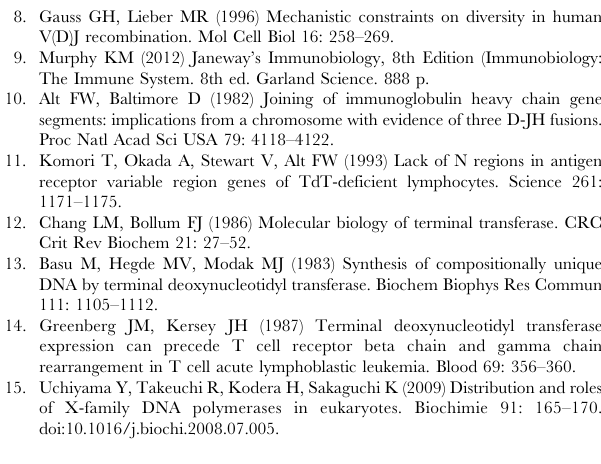
Table S3 General information on bovine gene segments JH1, JH2 and JH6. Table S4 Sequence analysis of CDR3H region. Nucleo- tides corresponding to V, D and J gene segments, N and P